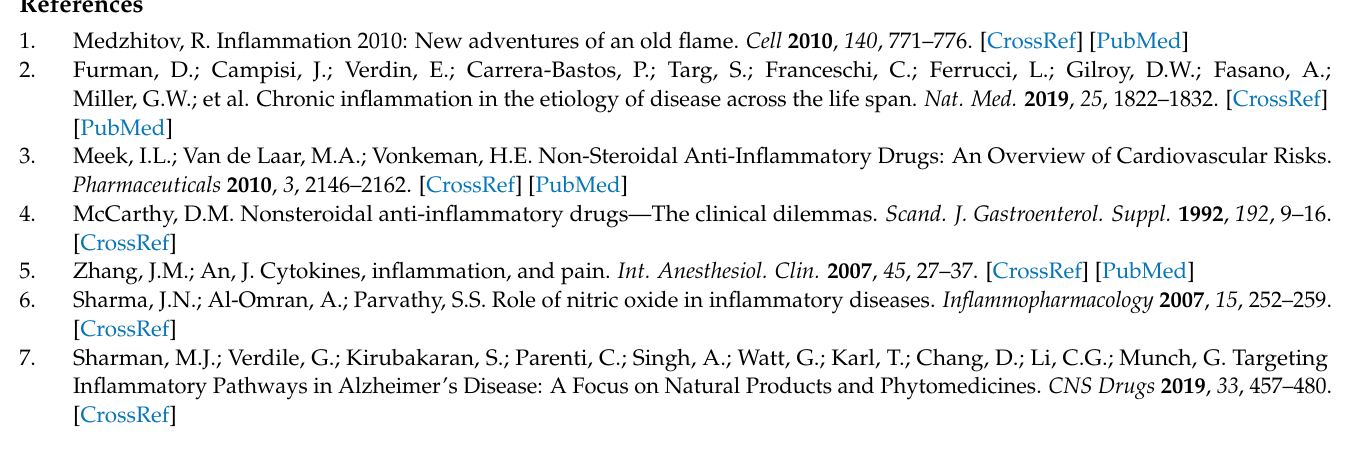
Figure S4. HSQC spectrum of compound 1 ; Figure S5. HMBC spectrum of compound 1 ; Figure S6. UV-Vis spectrum for compound 1 ; Figure S7. 1 H NMR spectrum of compound 2 ; Figure S8. 1 H NMR spectrum of compound 3 ; Figure S9. HRMS of compound 1 ; Figure S10. HRMS of compound 2 ; Figure S11. HRMS of compound 3 ; Table S1: Crystallographic data for compound 1 ; Table S2. Frac- tional Atomic Coordinates ( × 104) and Equivalent Isotropic Displacement Parameters (Å2 × 103) for compound 1 ; Table S3. Downregulation of LPS and IFN- γ induced production of pro-inflammatory markers (NO and TNF- α ) and cell viability of